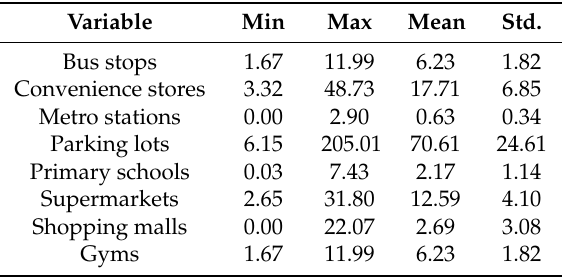
Table 2. Accessibility measures of amenities by